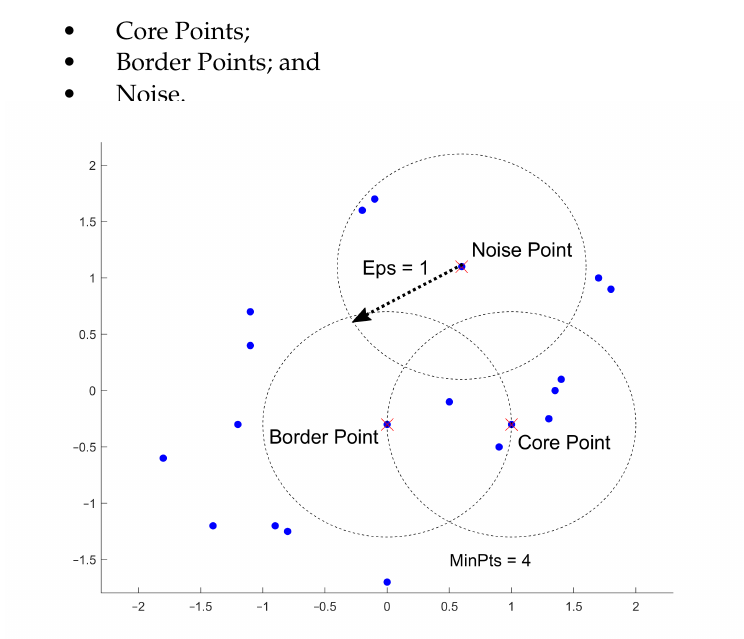
Figure 1. Definition of core, border and noise points.